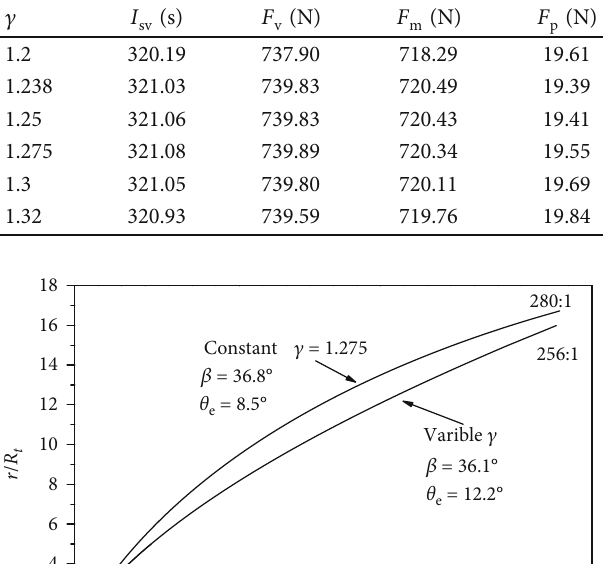
Figure 8: Comparison of Mach numbers in di ff erent